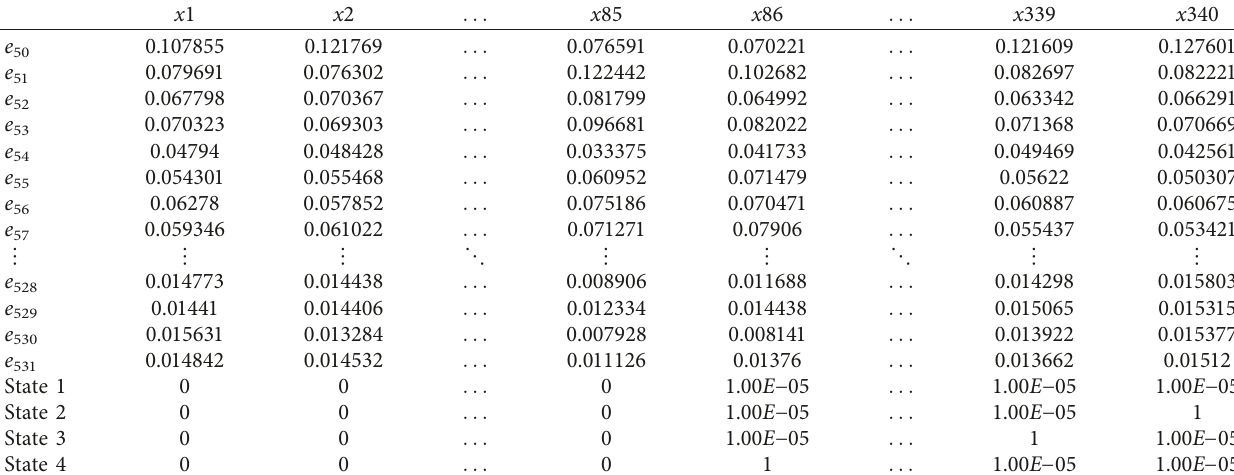
Figure 2: (a) Bearing test bench ( ① electric motor; ② insulated coupling; ③ principal axis; ④ supporting bearing pedestal; ⑤ current loading device; ⑥ test bearing’s bearing pedestal; ⑦ vibration acceleration sensor; ⑧ insulated bearing; ⑨ base; ⑩ current simulator); (b) sensors’ arrangement. d1, d2, and d3 represent direction 1, direction 2, and direction 3, respectively. Table 4: Joint score for the cross-validation set bearing status identification.